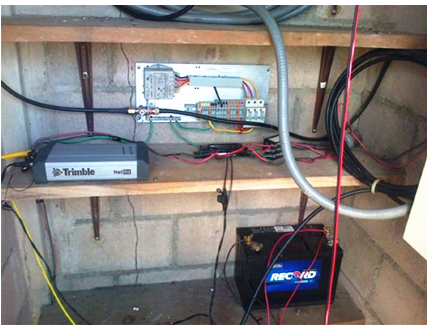
Figure 2. GPS hut located close to the San Miguel volcano (VMIG). Figure 3. GPS receiver installed at the San Miguel volcano